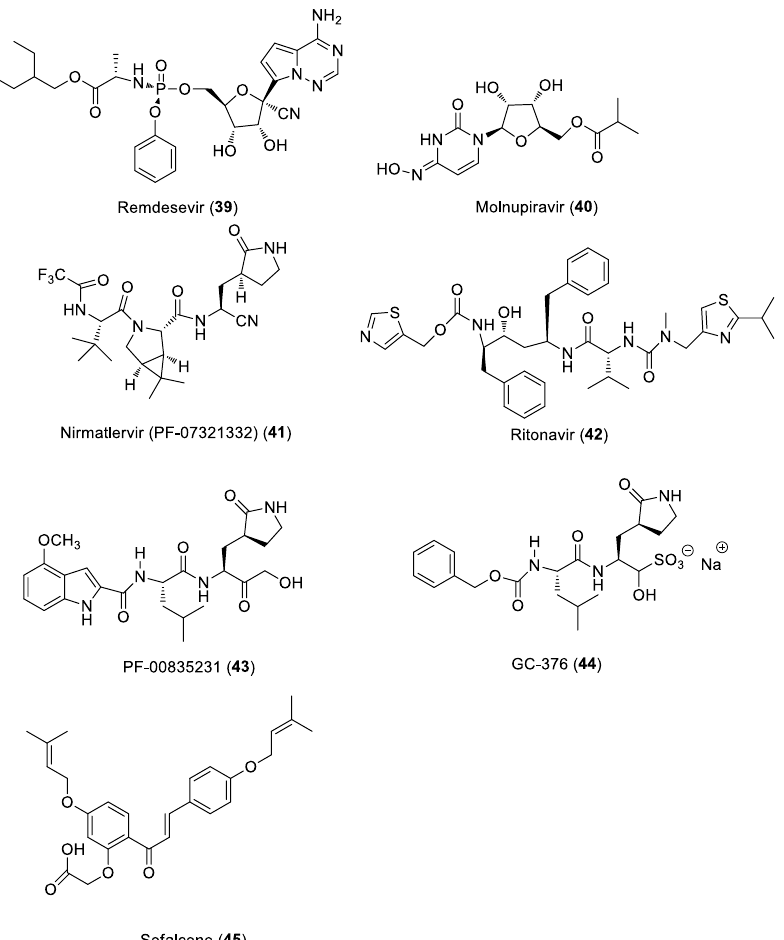
Figure 10. Direct-acting anti-SARS-CoV-2 agents.